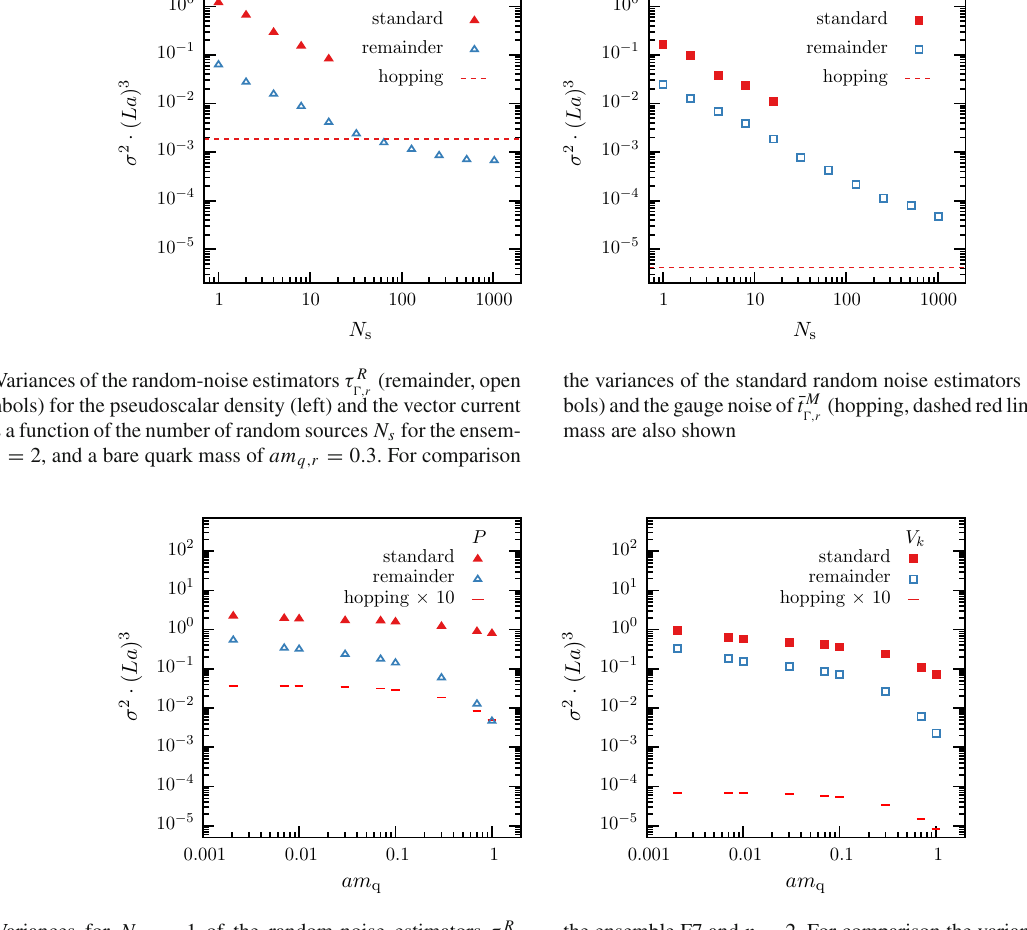
the ensemble F7 and n = 2. For comparison the variances of the stan- (cid:6), r dard random noise estimators (filled red symbols) and the gauge noise of ¯ t M (hopping, line symbols) for the same mass are also (cid:6), r